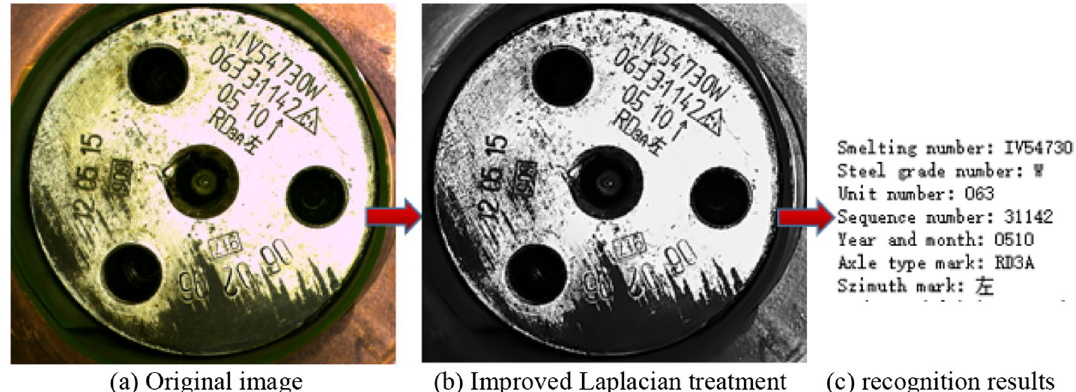
Fig. 9 Improved and enhanced algorithm processing effect and recognition